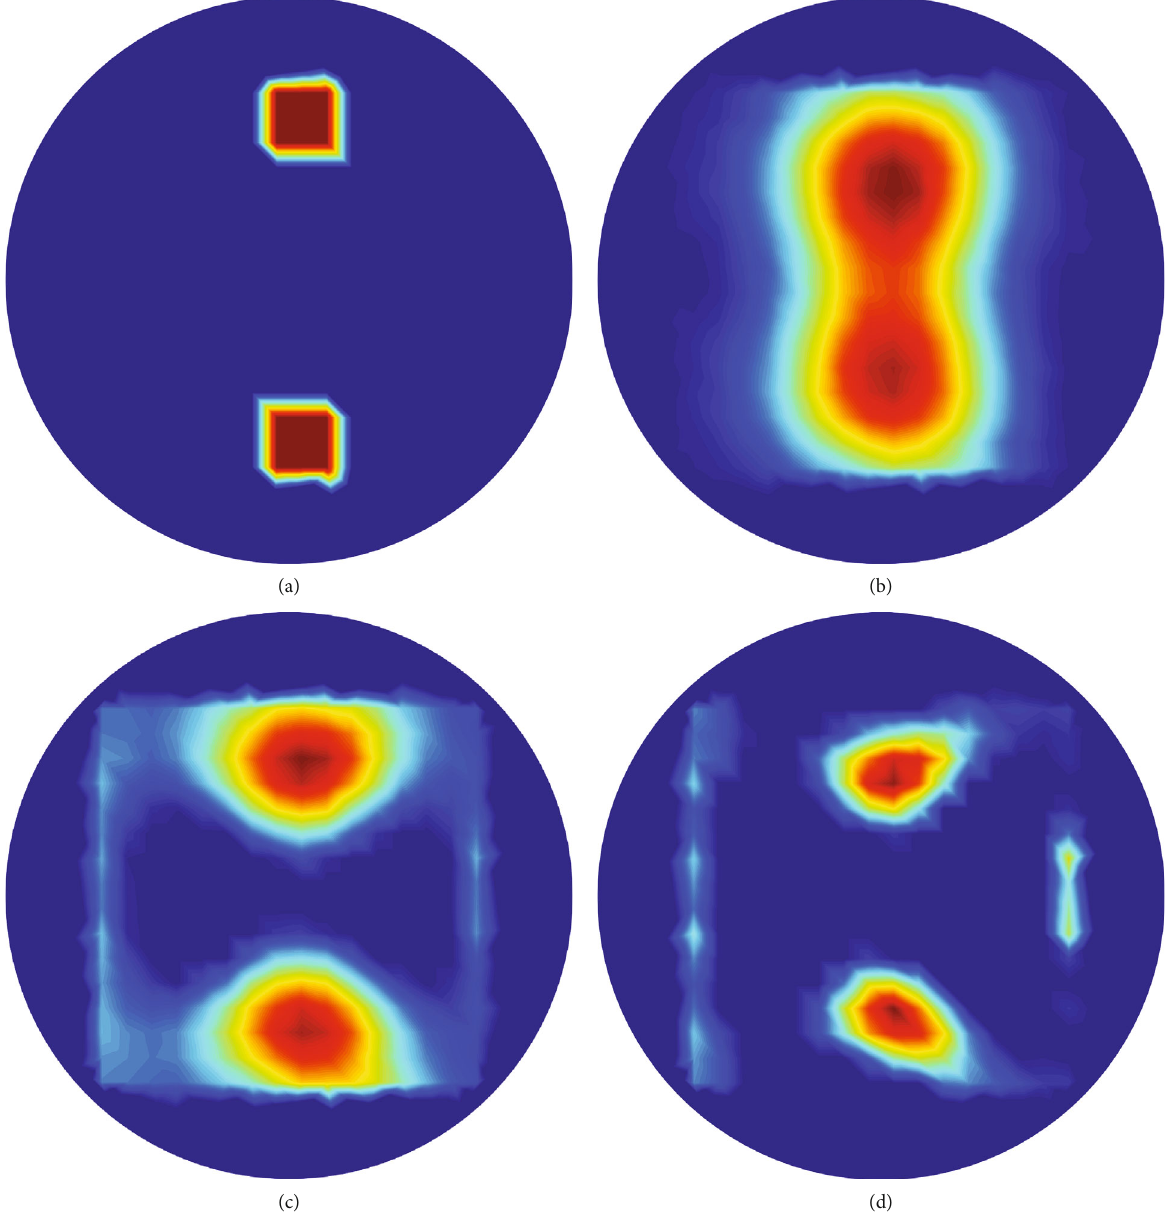
Figure 12: Reconstructed tomographic images on FPGA SoC using LBP and iLBP algorithms. (a) Original image. (b) LBP. (c) iLBP 10. (d) iLBP